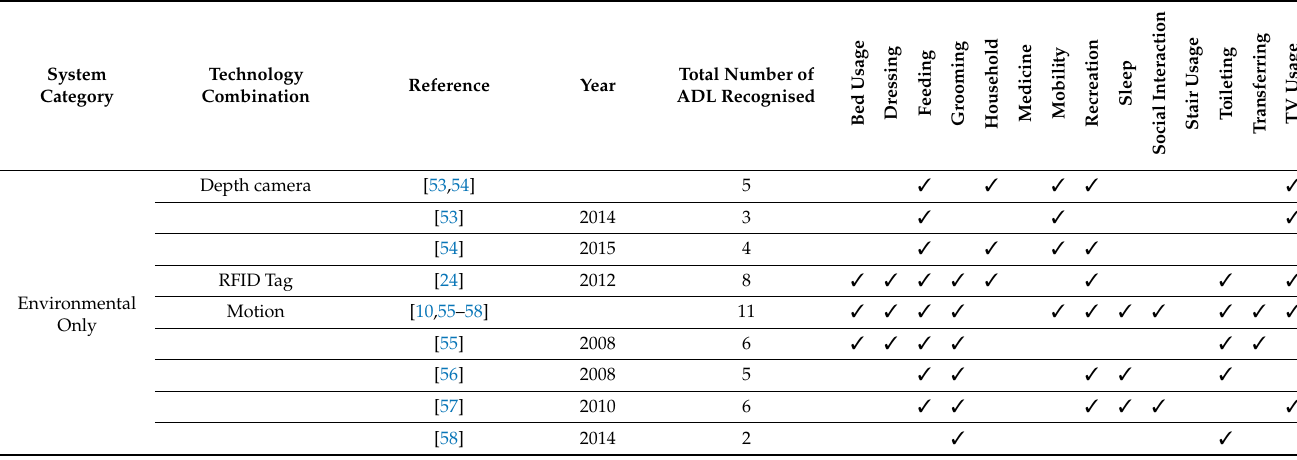
Table 4. Summary of the identified systems, including the system category, technology type included, and the ADL recognised. The systems corresponding to the references can be found in Table